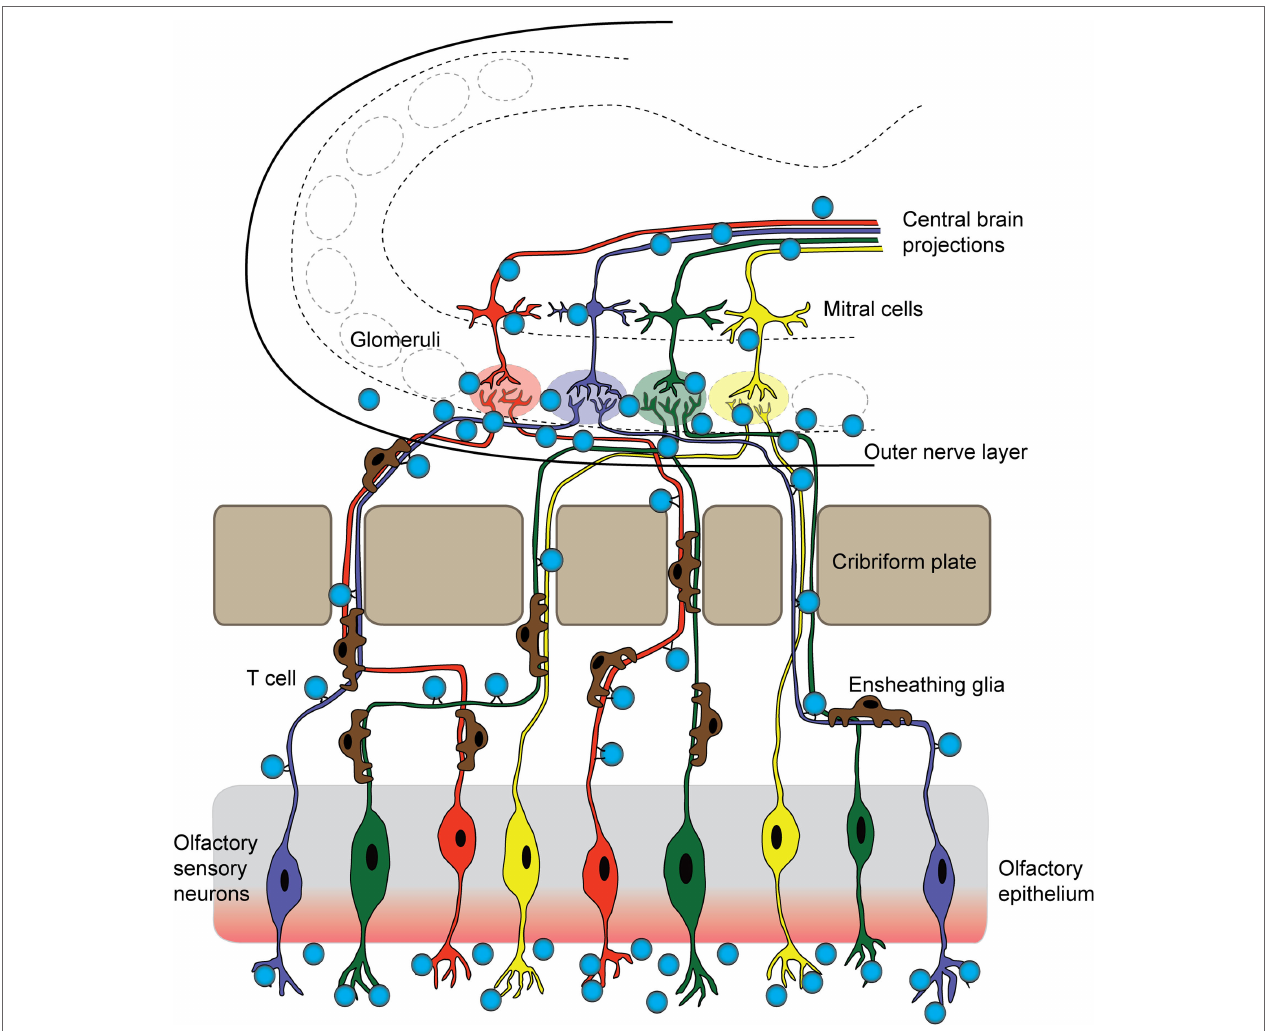
FiGURe 2 | T cells originating in the nose infiltrate the brain parenchyma . In a mouse model for pediatric autoimmune neuropsychiatric disorders associated with streptococcal infections, T cells first arise in the nasal-associated lymphoid tissue and olfactory epithelium at the site of a latent S. pyogenes infection. These cells then respond to chemotactic cues release by olfactory ensheathing glia to accompany sensory axons into the brain. Once there, infiltrating T cells release inflammatory cytokines and chemokines, damaging synapses within olfactory glomeruli and breaking down tight junctions of olfactory bulb capillaries. These T cells may then move centrally, against the rostral migratory stream and toward the SVZ, and exit through the ventricles, or continue following the projections of olfactory mitral/tufted